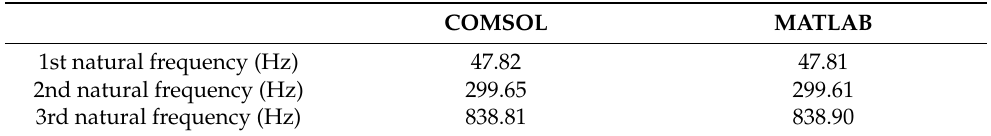
Table 2. Comparing the values of the natural frequencies obtained from COMSOL and MATLAB software (The MathWorks, Natick, MA, USA).